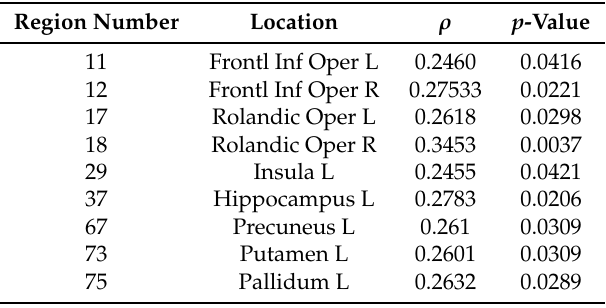
Table 3. Regions with significant correlation between grey matter volume and MMSE across AD and HC